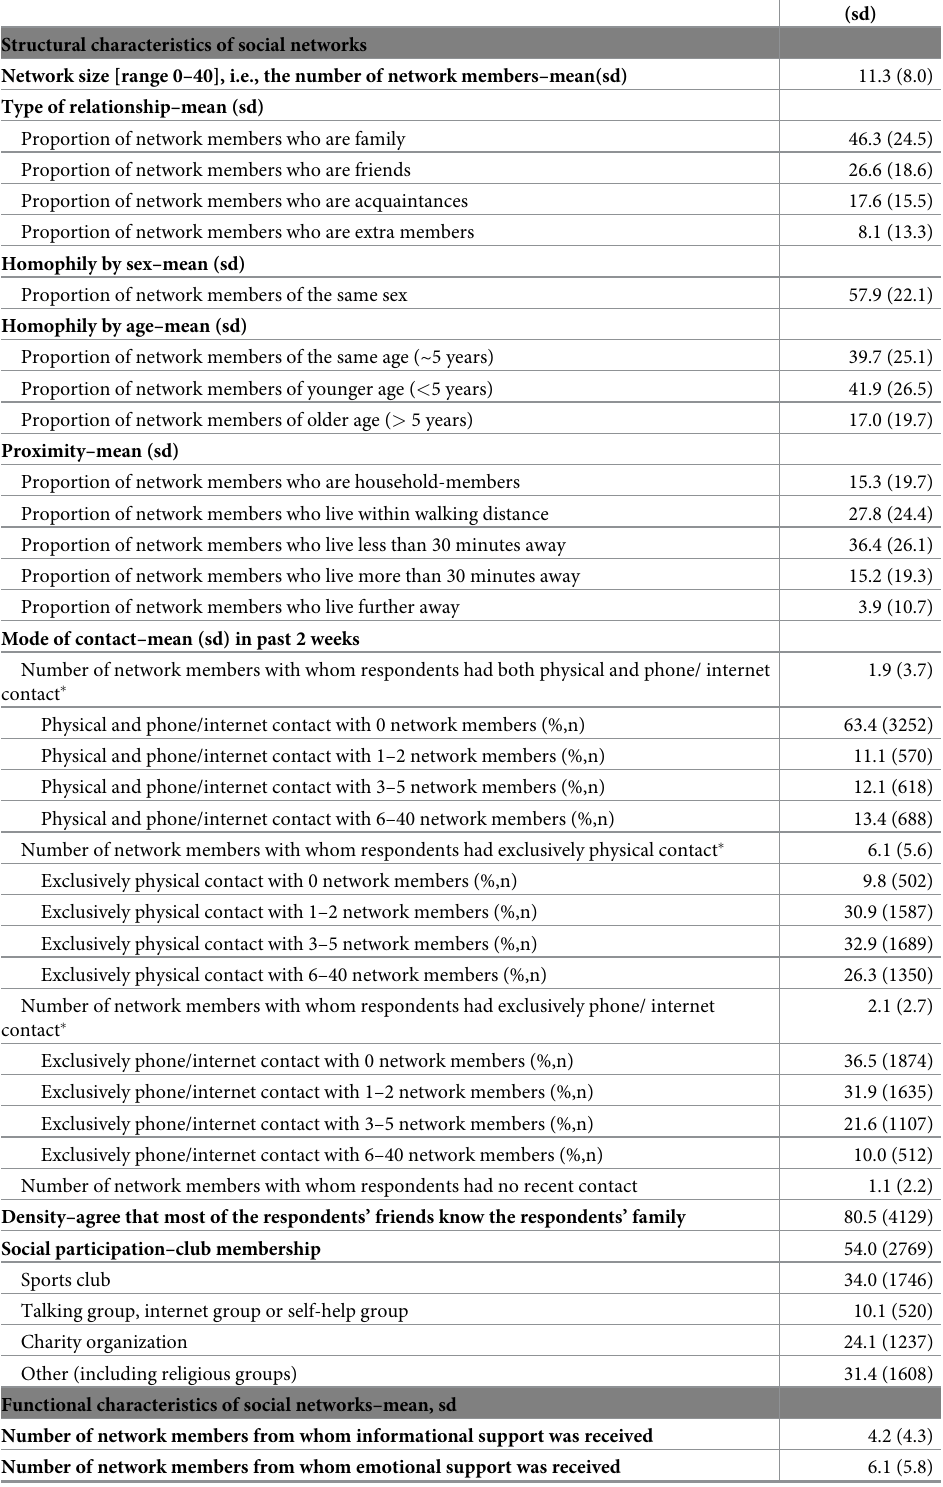
Table 2. Social network characteristics of the SaNAE study population (n =